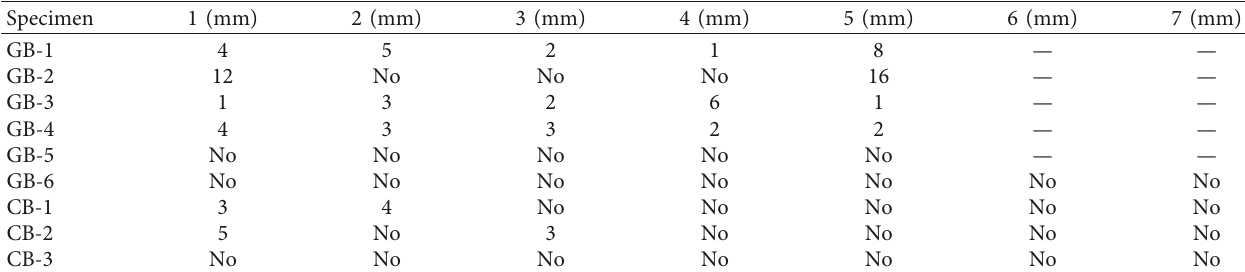
Table 9: Slip displacement of screw-thread steels and CFRP bars.